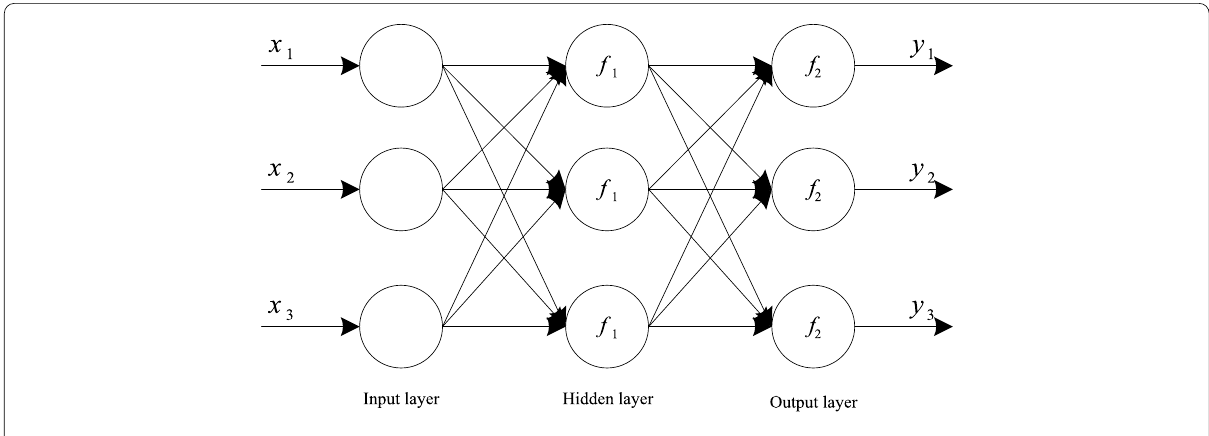
Figure 2 BP neural network prediction